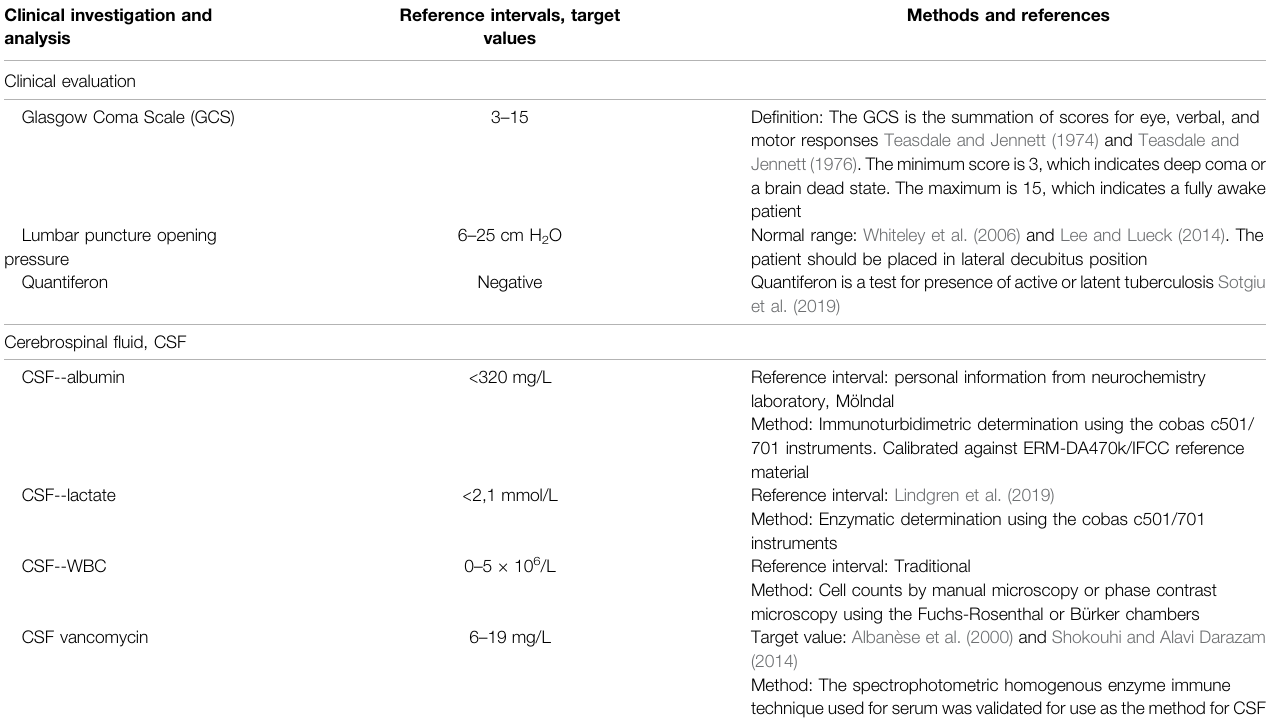
TABLE 1 | De fi nitions, methods, and reference